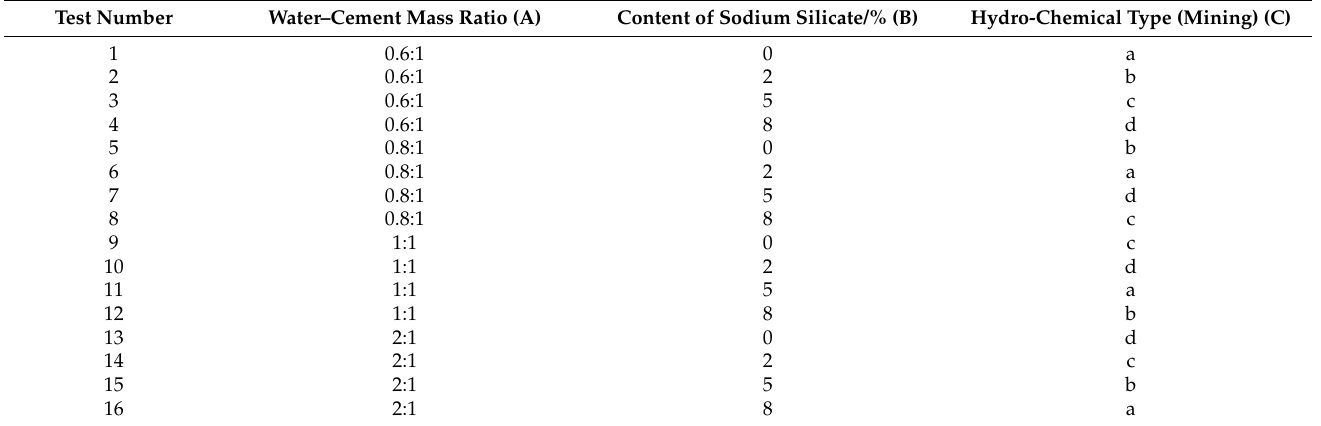
Table 4. Orthogonal test scheme for cement grout.